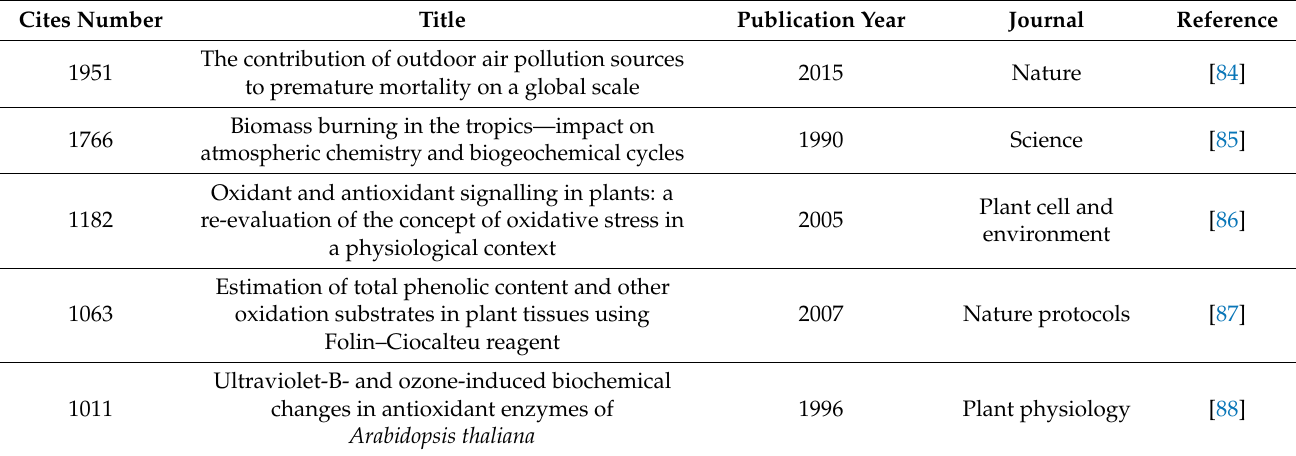
Table 3. Ranking of the five most cited articles in the research field of ozone in